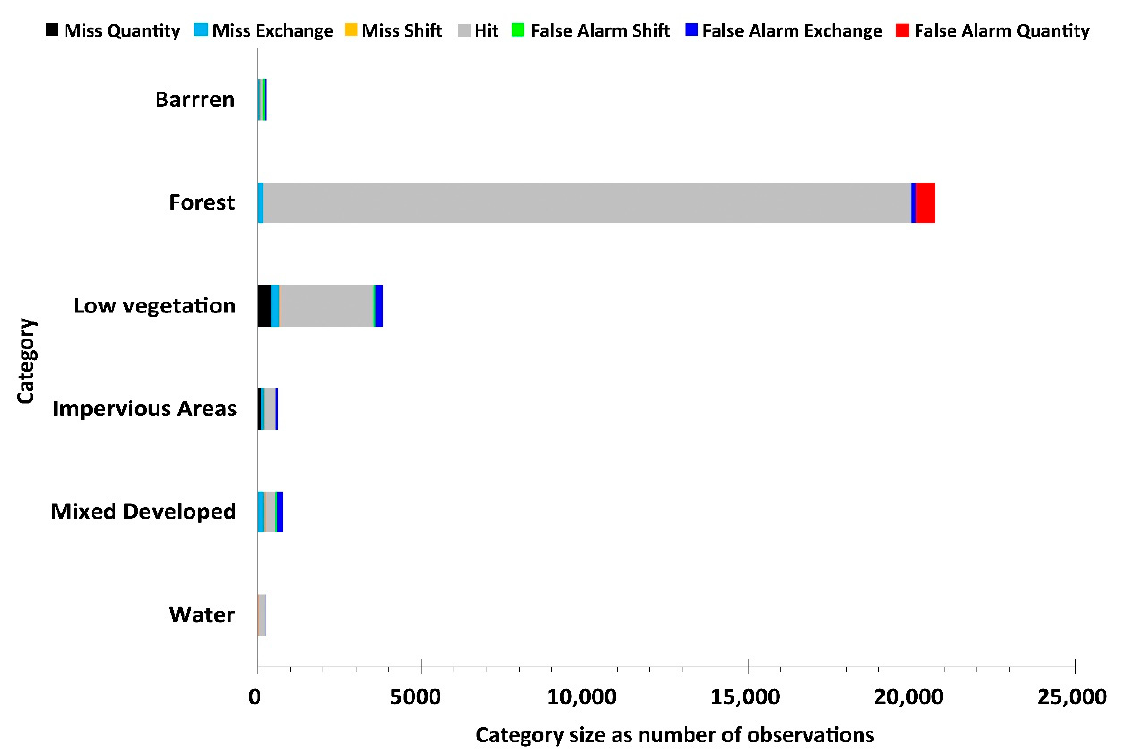
Figure 6. Category size errors for 2016. Miss and false alarm as number of observations.